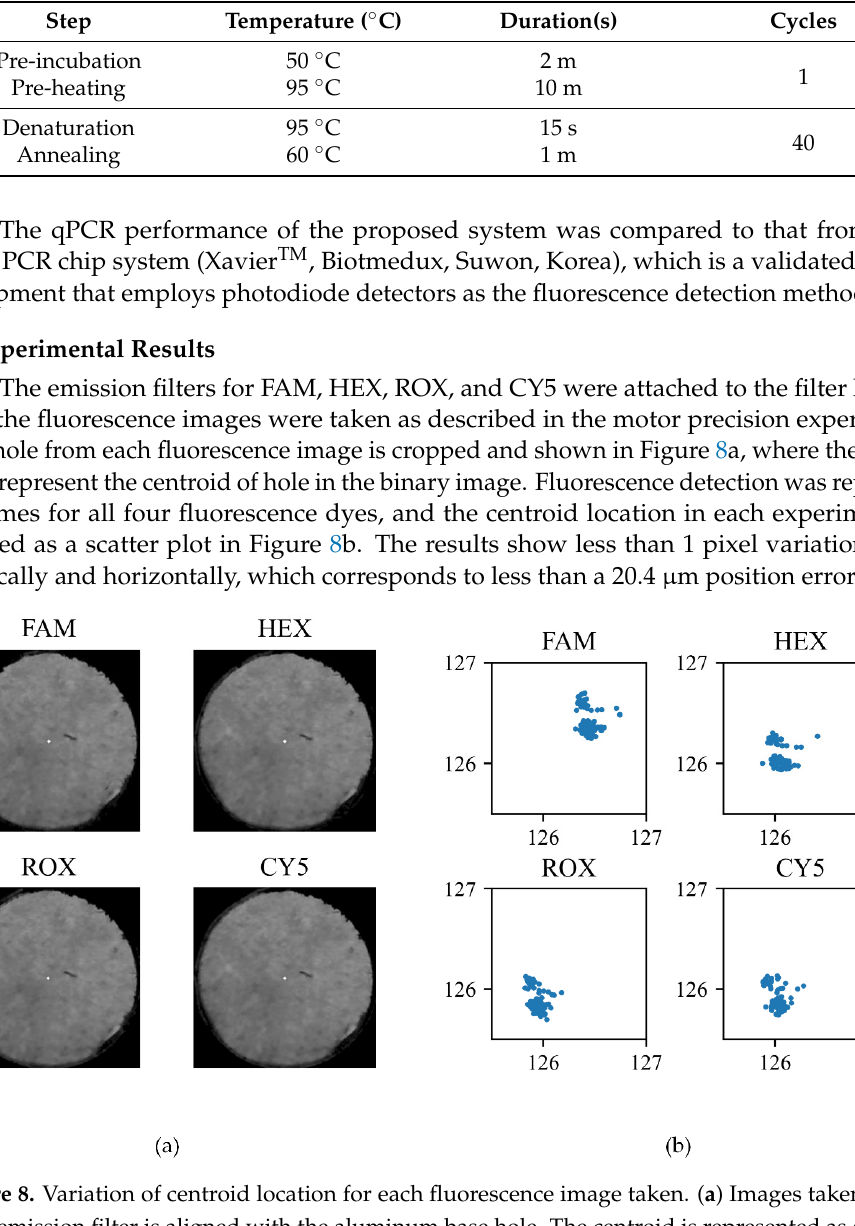
Table 4. Real-time PCR protocol.